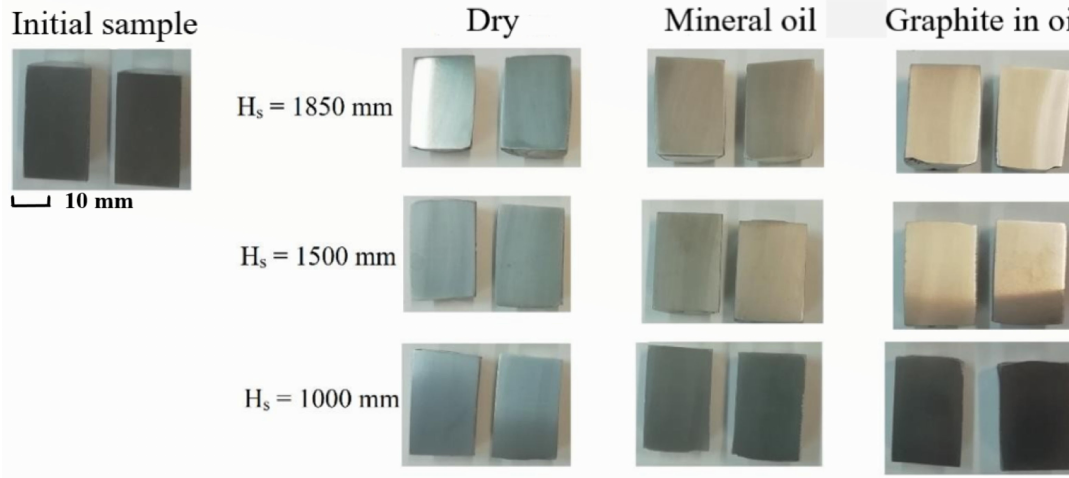
Figure 14. Samples were sectioned and prepared for hardness tests.